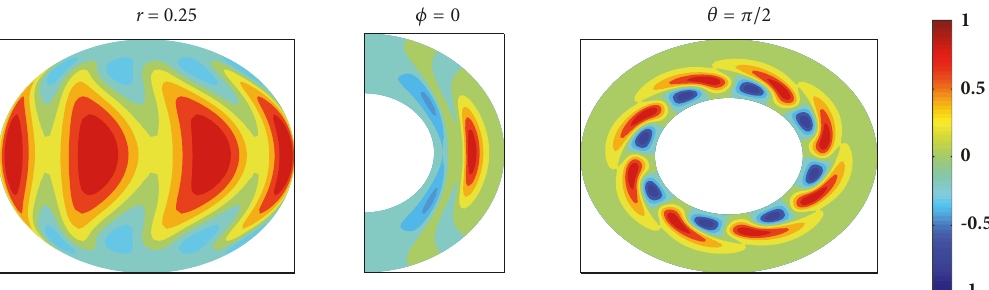
Figure 16: A snapshot showing the contour levels of Θ at the indicated surfaces for 𝑅 = 8 ⋅ 10 5 .